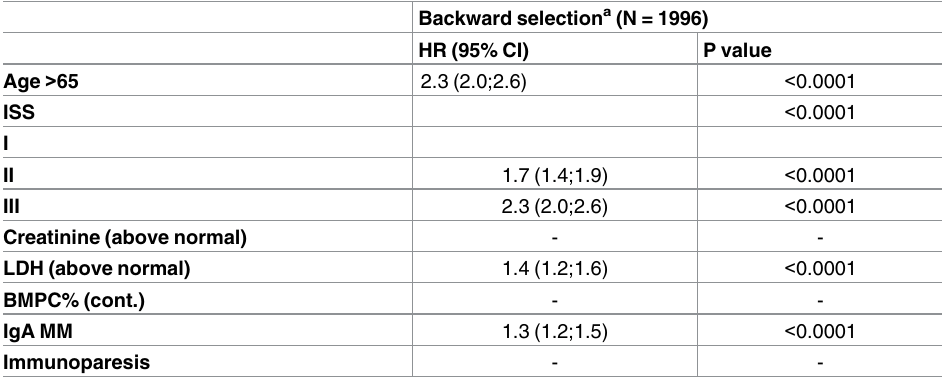
Table 2. Multivariable analysis of factors for OS.